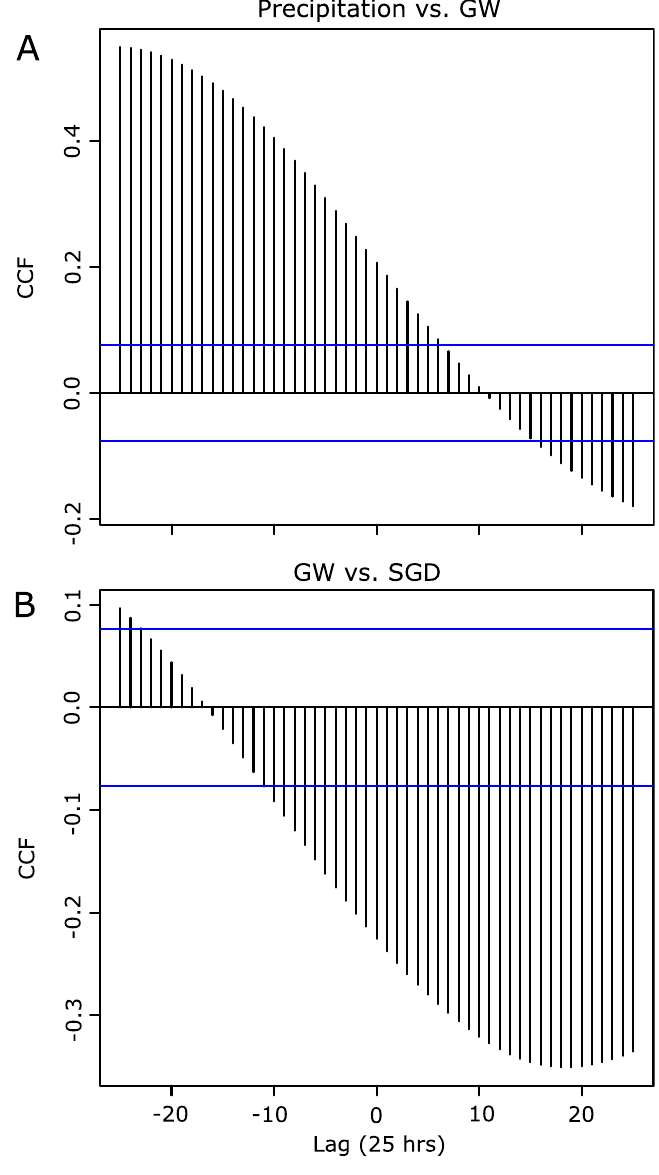
Figure 5. Cross correlation (CCF) between the 25-h resampled trend component for precipitation and groundwater levels ( A ) and groundwater levels and SGD ( B ). The blue lines indicate that the cross correlation is significant at the 95% confidence interval, thus any value outside of the lower and upper bands is significant. The gradual slope on both cross-correlation plots indicates that impacts from precipitation on groundwater ( A ) and groundwater on SGD ( B ) are not instantaneous but accumulate and get pronounced over